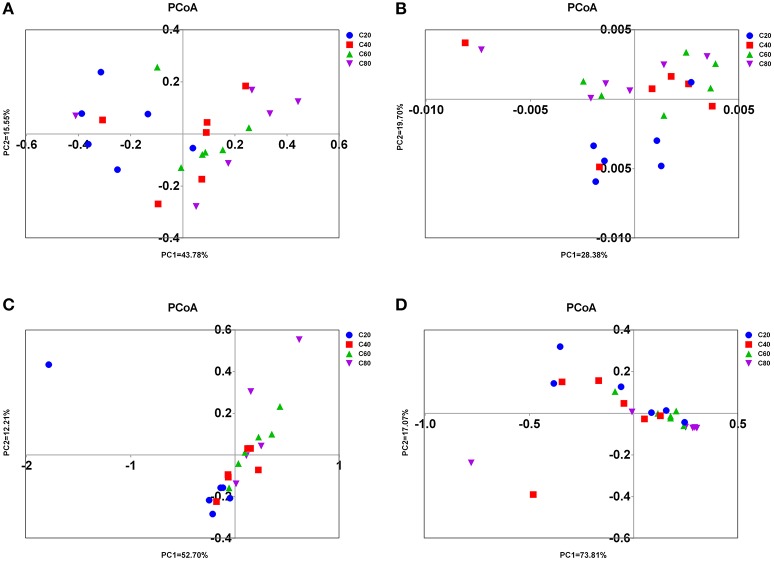
PCoA of rumen microbial communities. Weighted PCoA by ruminal bacteria (A), ciliate protozoa (B), anaerobic fungi (C), and archaea (D) microbiota. C20, diet containing 20% of concentrate; C40, diet containing 40% of concentrate; C60, diet containing 60% of concentrate; C80, diet containing 80% of concentrate.